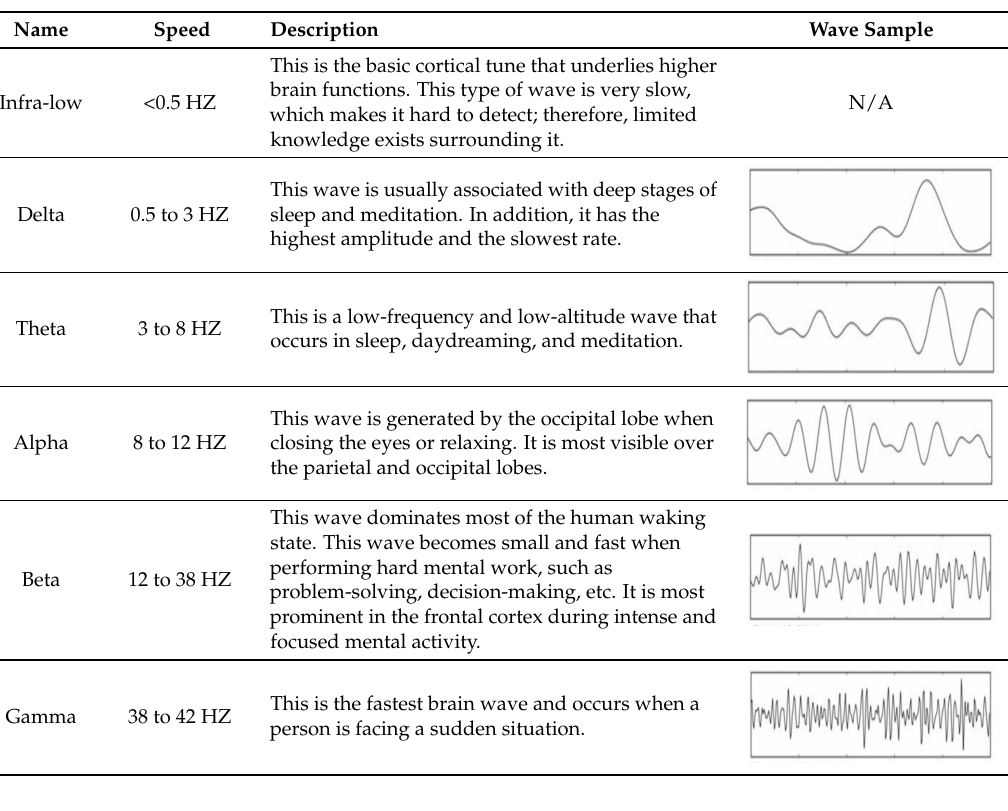
Table 1. Brainwave bandwidths and functions.